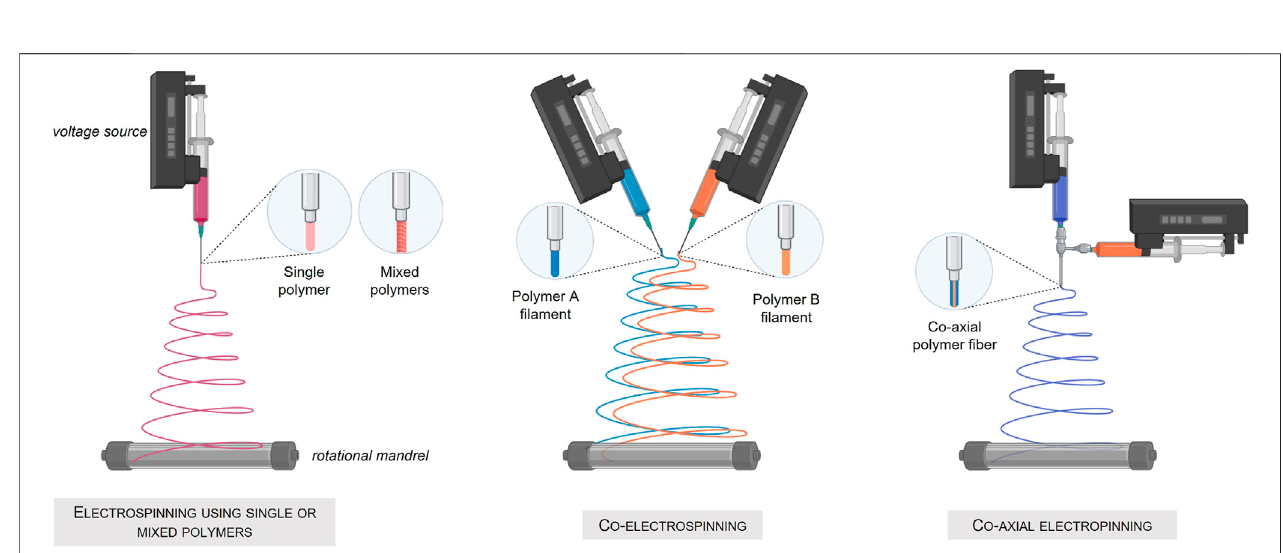
FIGURE 4 | Fabrication of tissue engineered blood-vessel by the electrospinning technique. (A) Electrospinning using a single or mixed polymer. (B) Co- electrospinning of two different polymers. (C) Co-axial electrospinning.